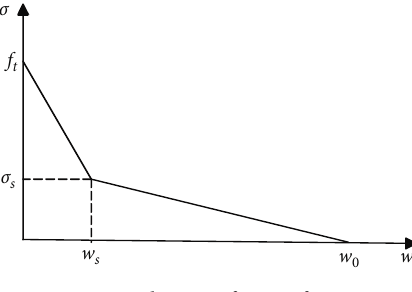
Figure 8: Bilinear softening